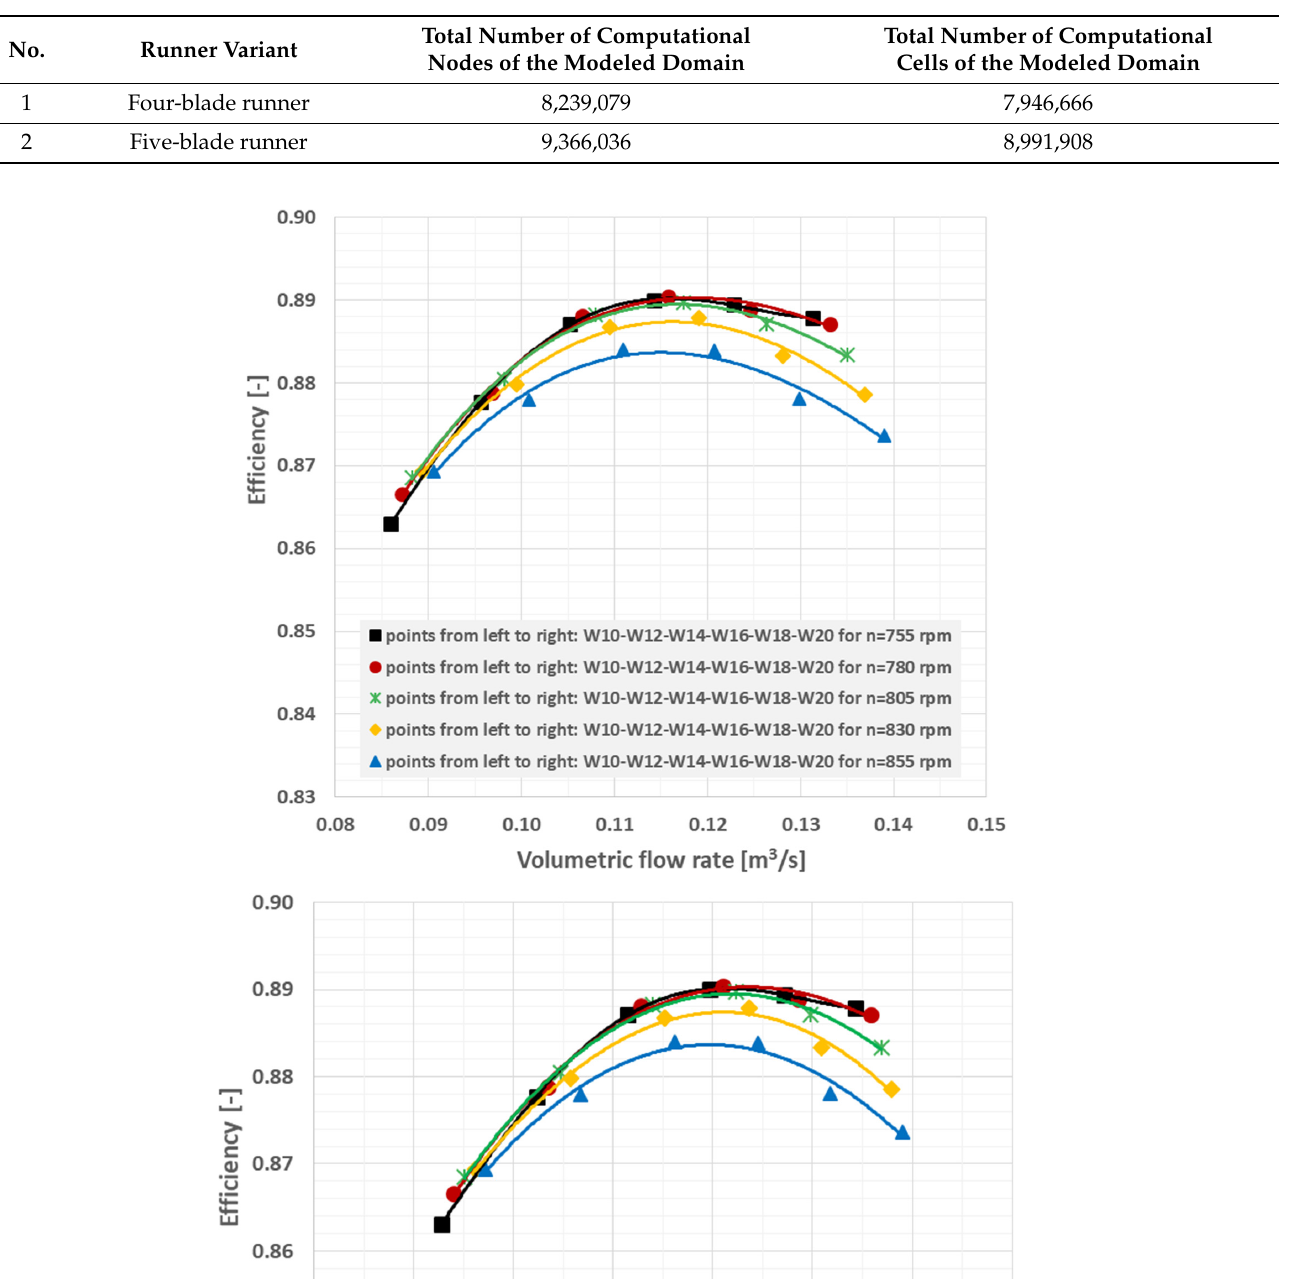
Table 1. Number of nodes and computational cells of the computational domain for each variant of the runner configuration.